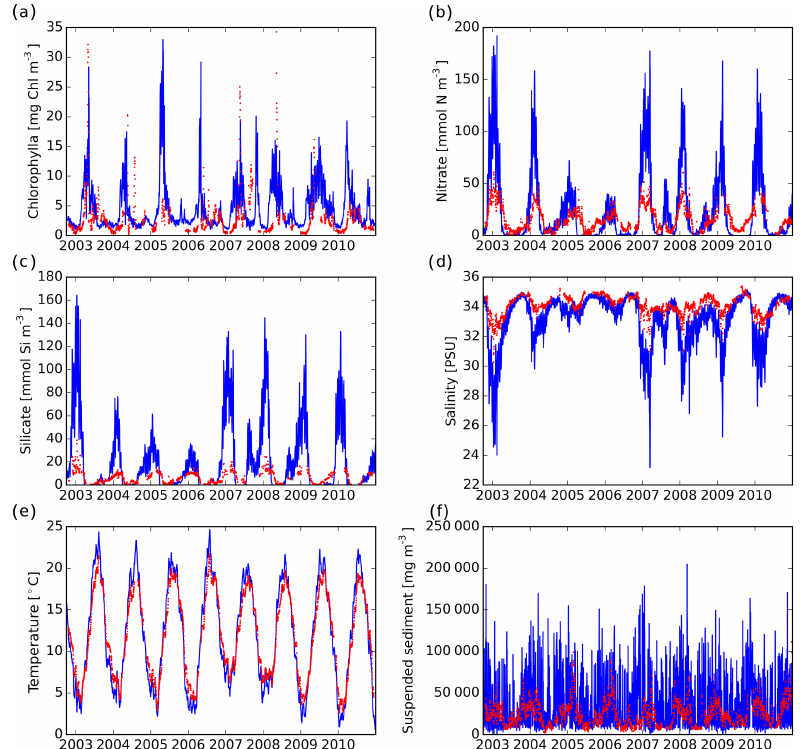
Figure 6. Time series comparison with Warp Anchorage SmartBuoy at the surface. Blue: model; red: observations. (a) Chlorophyll- a concentration; (b) nitrate concentration; (c) silicate concentration; (d) salinity; (e) temperature; (f) suspended sediment